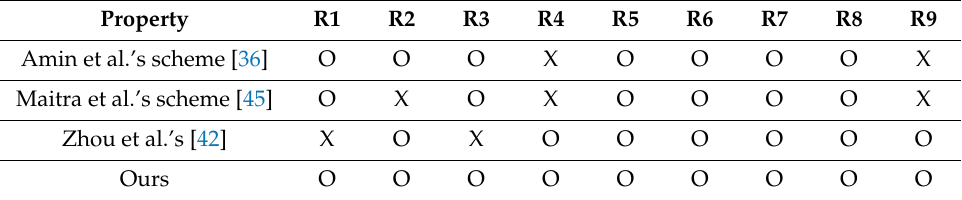
Table 1. Comparison of Security Properties among Four Authentication